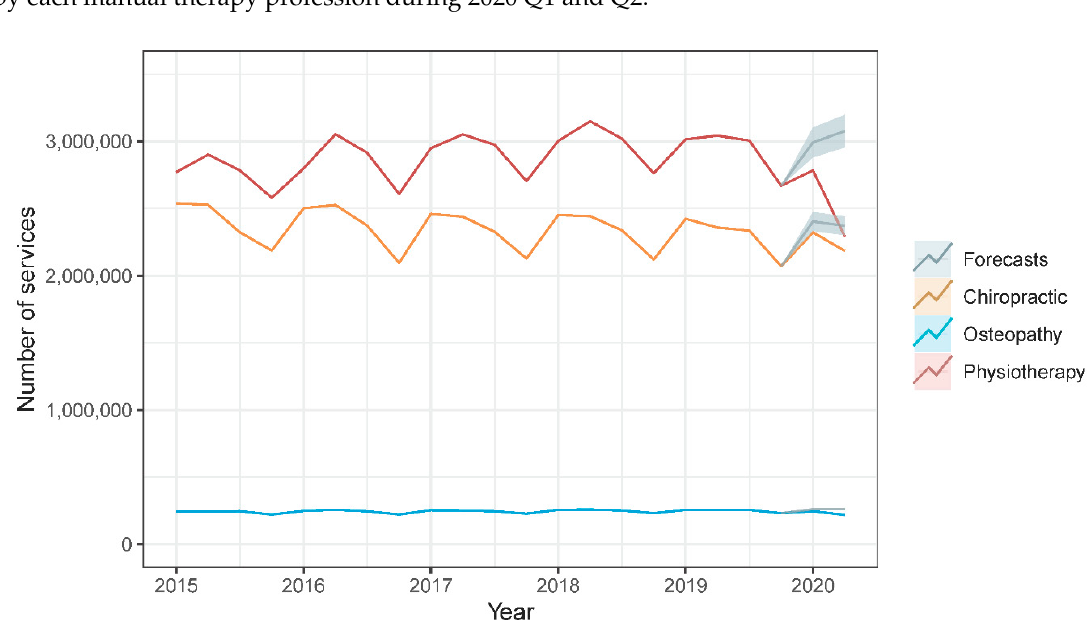
Figure 1. Time series plot of observed values and point forecast estimates with 95% prediction intervals of the quarterly number of services provided by each manual therapy profession from 2015 to 2020 Q2.